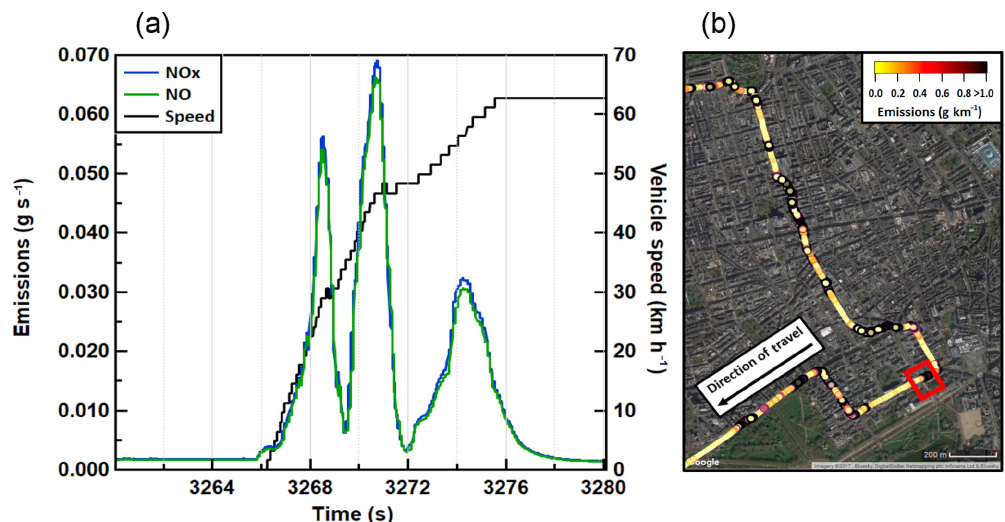
Figure 3. Time series of NO x , NO, emissions in gs − 1 of the diesel vehicle with vehicle speed of a traffic light pull-away in central London, UK. The red box represents the spatial component of the graph data, shown in the context of the city